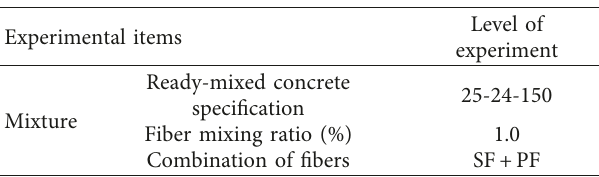
Figure 11: (a) Field application architecture perspective and (b) cross-sectional view. Table 6: Field test